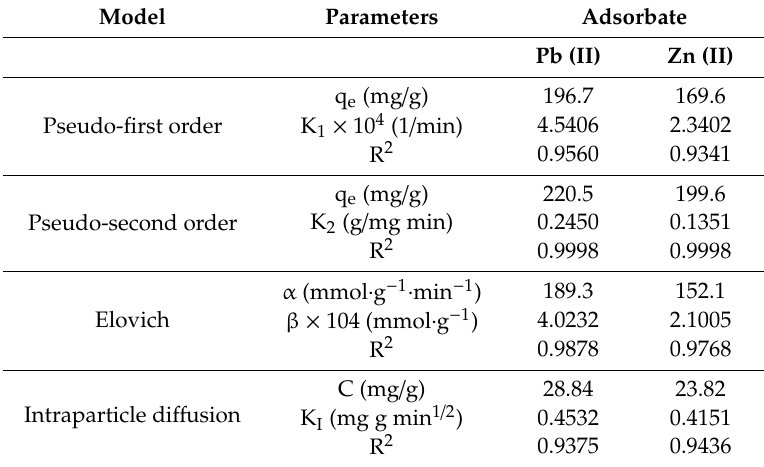
Table 5. Determined kinetic parameters for the adsorption of Pb(II) and Zn(II) on GO, Conditions: pH = 5.5; T = 298 K; into an aqueous solution of initial concentration 25 mg L − 1 .